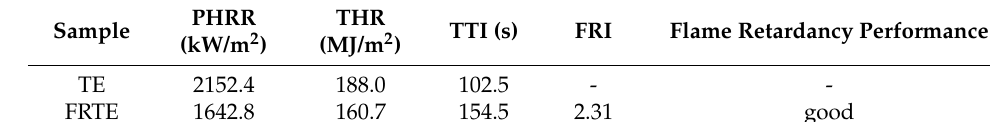
Table 1. The parameters obtained from the cone calorimeter measurement.